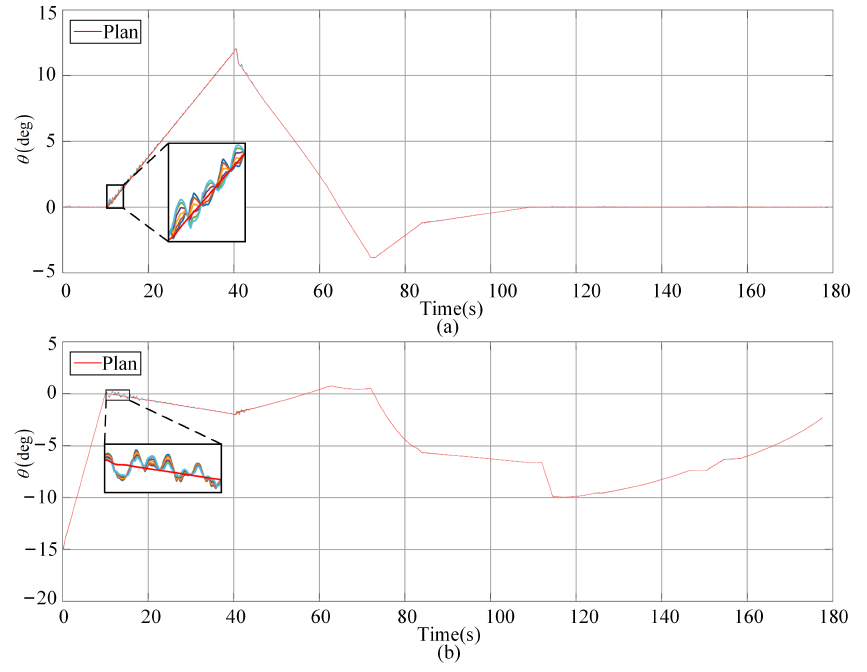
Figure 15. The comparison between the planning curve and the simulation curve of the six cross-axis joints of the 5th segment. ( a ) Alpha direction. ( b ) Beta direction.